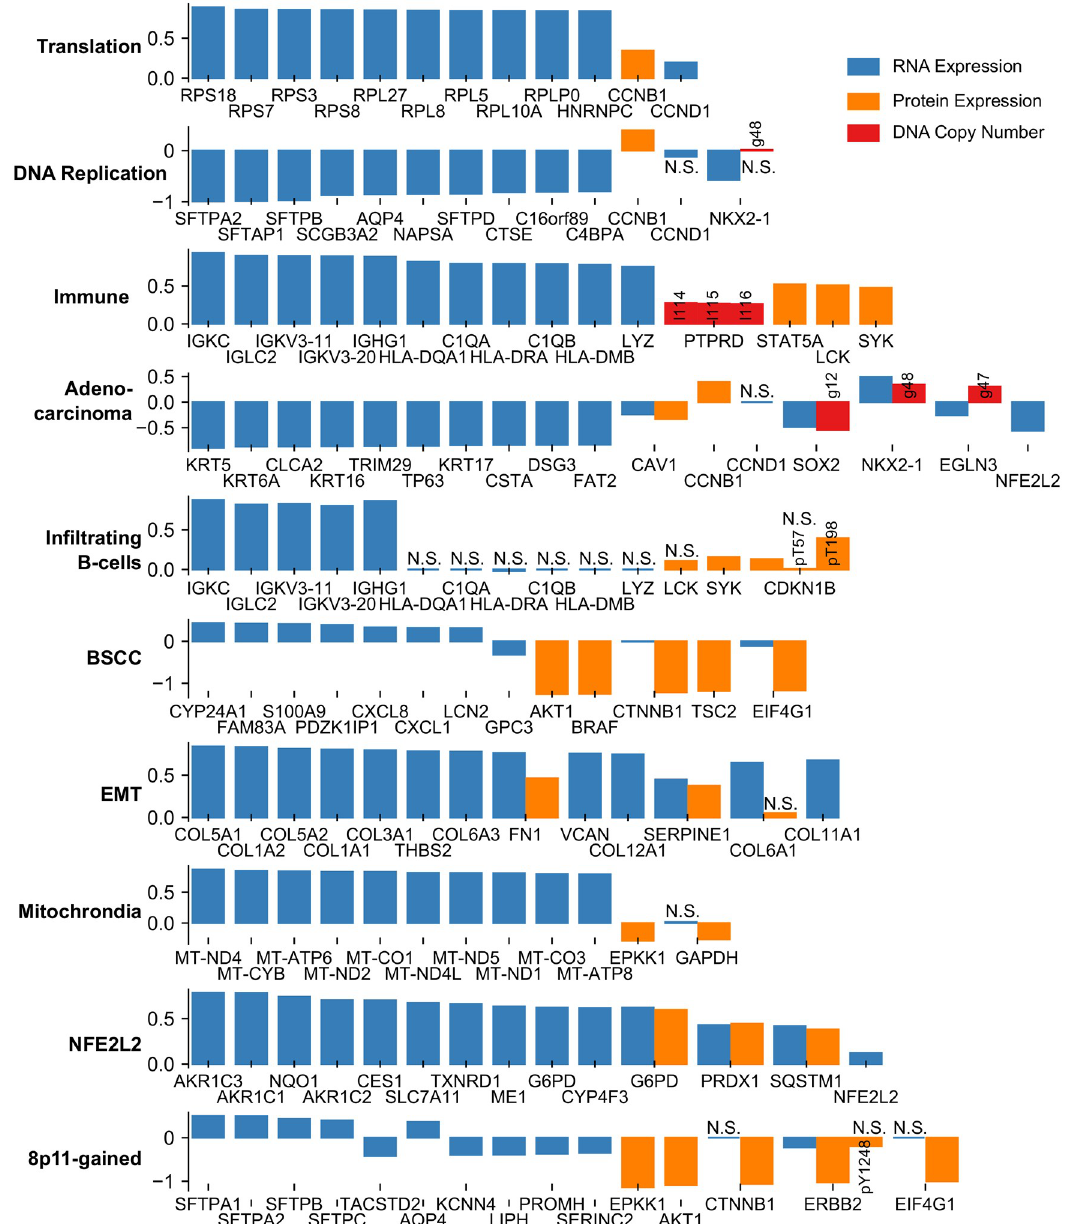
Fig 6. The strongest SFA coefficients for the lung cancer data set for each of the three data types and all ten factors. Height of the bars shows the values of the coefficients. Non-significant coefficients (p > 0.05, signifance test of coefficient in an ordinary least- squares model) are marked with N.S. If a gene is shown we show all coefficients of that gene in the model. RNA expression coefficients are shown in blue. Protein expression coefficients are shown in orange. Any modifications of an epitope are noted in a short text description. pX = phosphorylated at residue X. DNA copy number coefficients are shown in red. Numbers refer to the recurrently aberrated loci in S5 Table. Recurrent gains are prefixed with a g, losses with an l. Also see S2 Table.